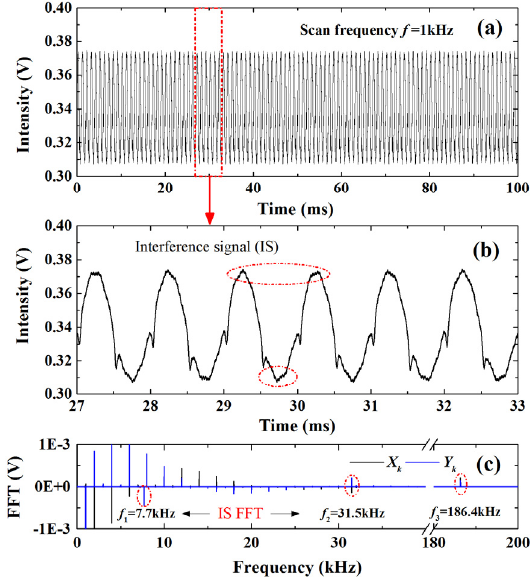
Figure 4. ( a ) Detected transmitted light intensity with several disturbance signals. ( b ) The enlarged figure of the transmitted light intensity. ( c ) Fourier coefficients X k and Y k of the transmitted light intensity with 100 cycles. The experimental conditions are: CO/N 2 mixture gas, T = 299 K, L = 14.7 cm, Xco = 1.02%, P = 101.3 kPa.